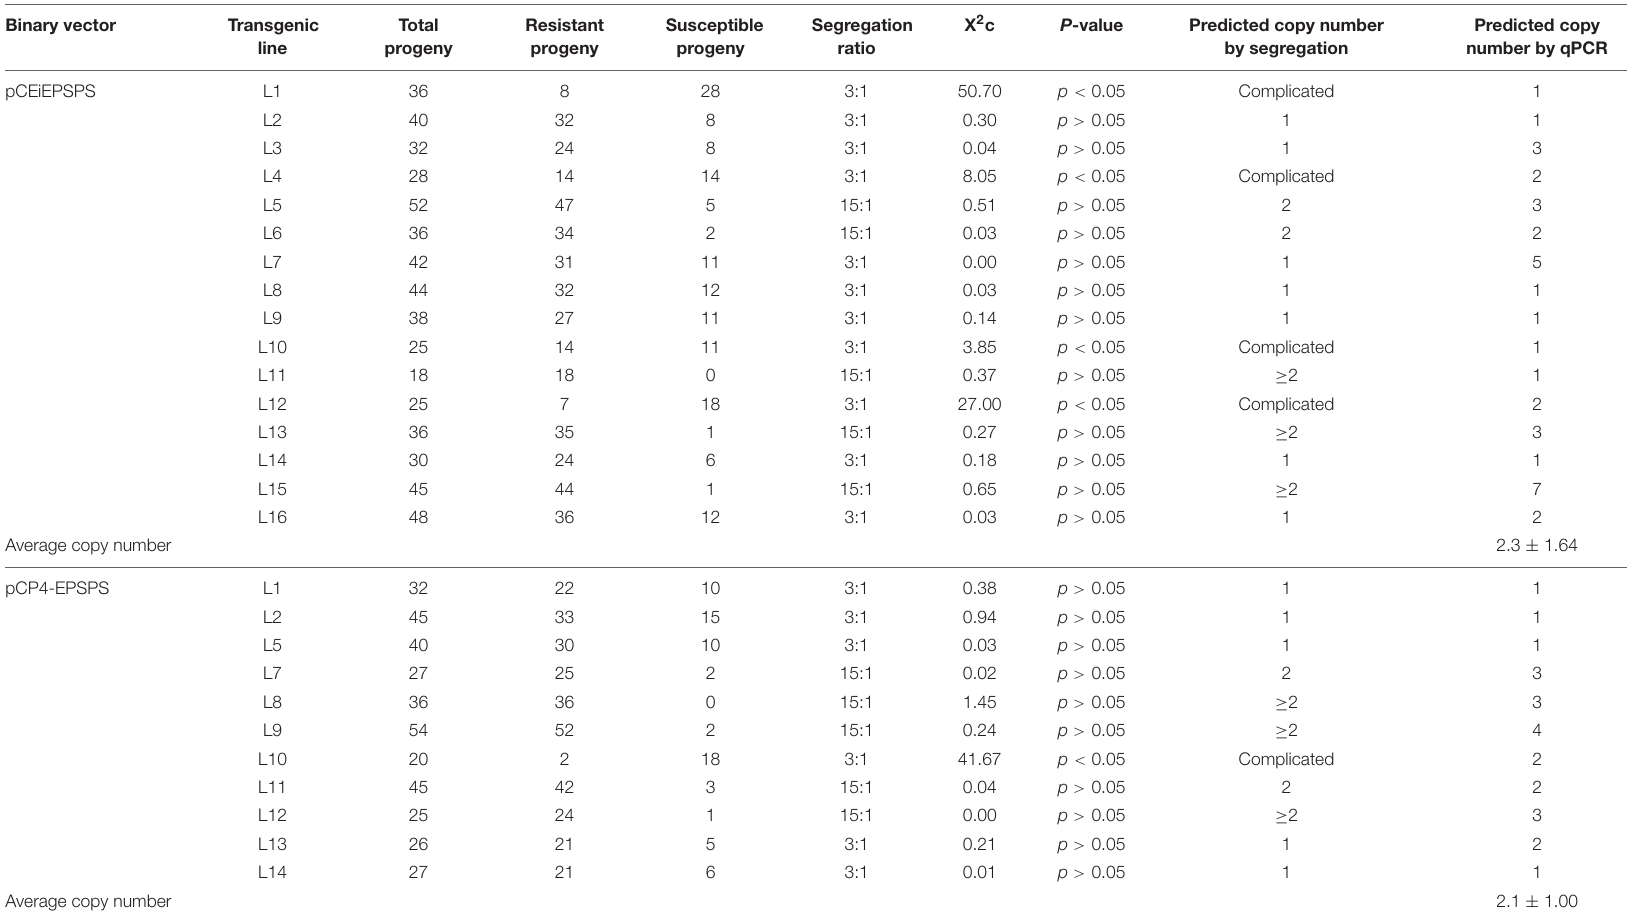
TABLE 2 | Transgene copy number of the binary vector pCEiEPSPS and pCP4-EPSPS detected by segregation and quantitative PCR (qPCR). Binary